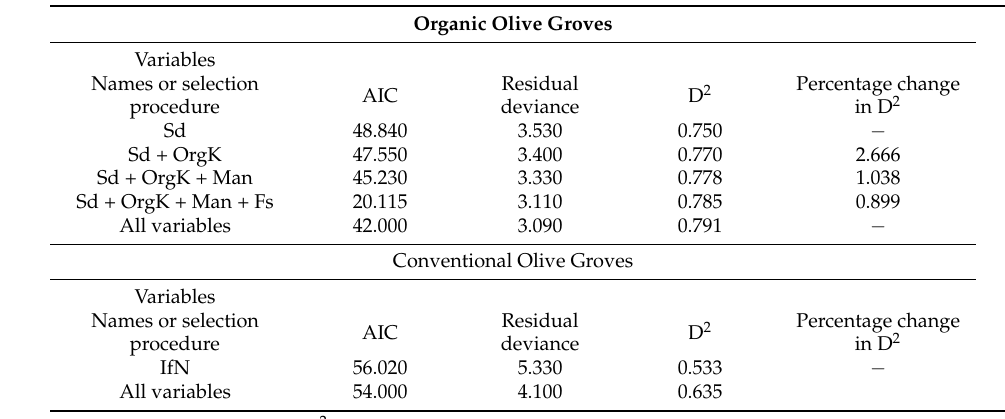
Table 4. Selection of model variables.